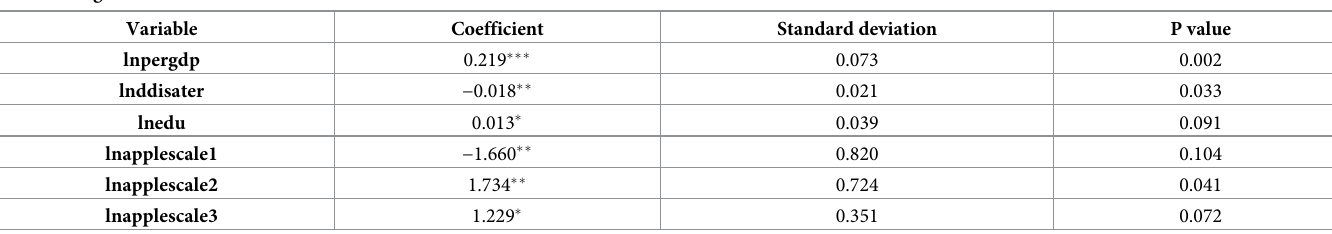
Table 5. Regression results of the threshold